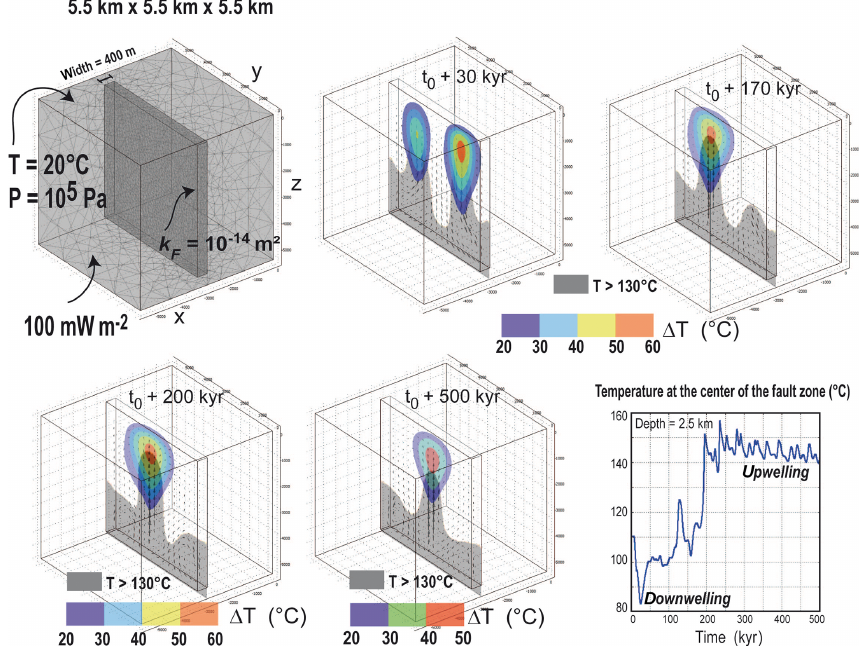
Figure 8. Case of a wide vertical fault zone in a 3D block, with realistic fluid properties and boundary conditions. Fault permeability is fixed at 10 − 14 m 2 . Positive temperature anomalies greater than 20 ◦ C are colored in the middle plane of the fault zone. Zones in which temperature exceeds 130 ◦ C are shown in grey. Temperature evolution at the center of the fault zone illustrates the transition from a downwelling to an upwelling from 150 to